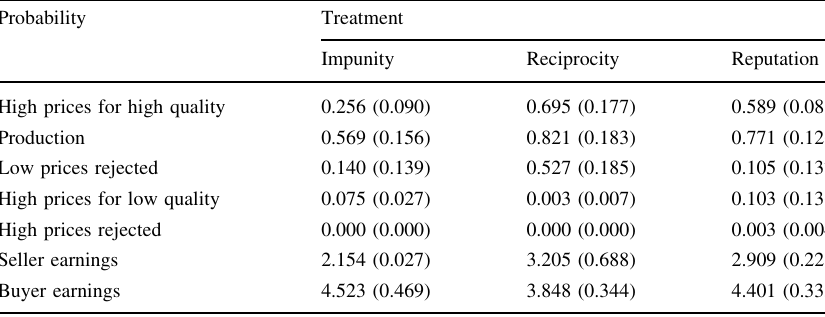
Table 1 Summary